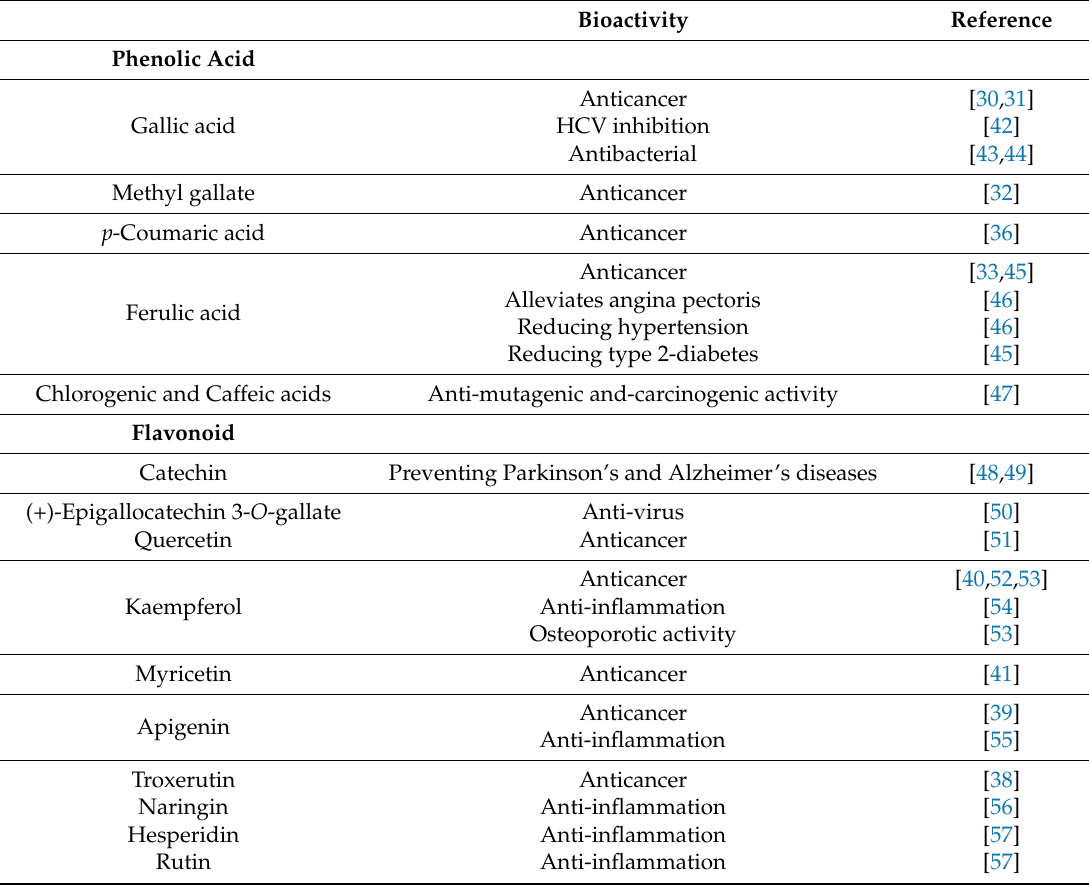
Table 1. Bioactivities of phenolic acids and